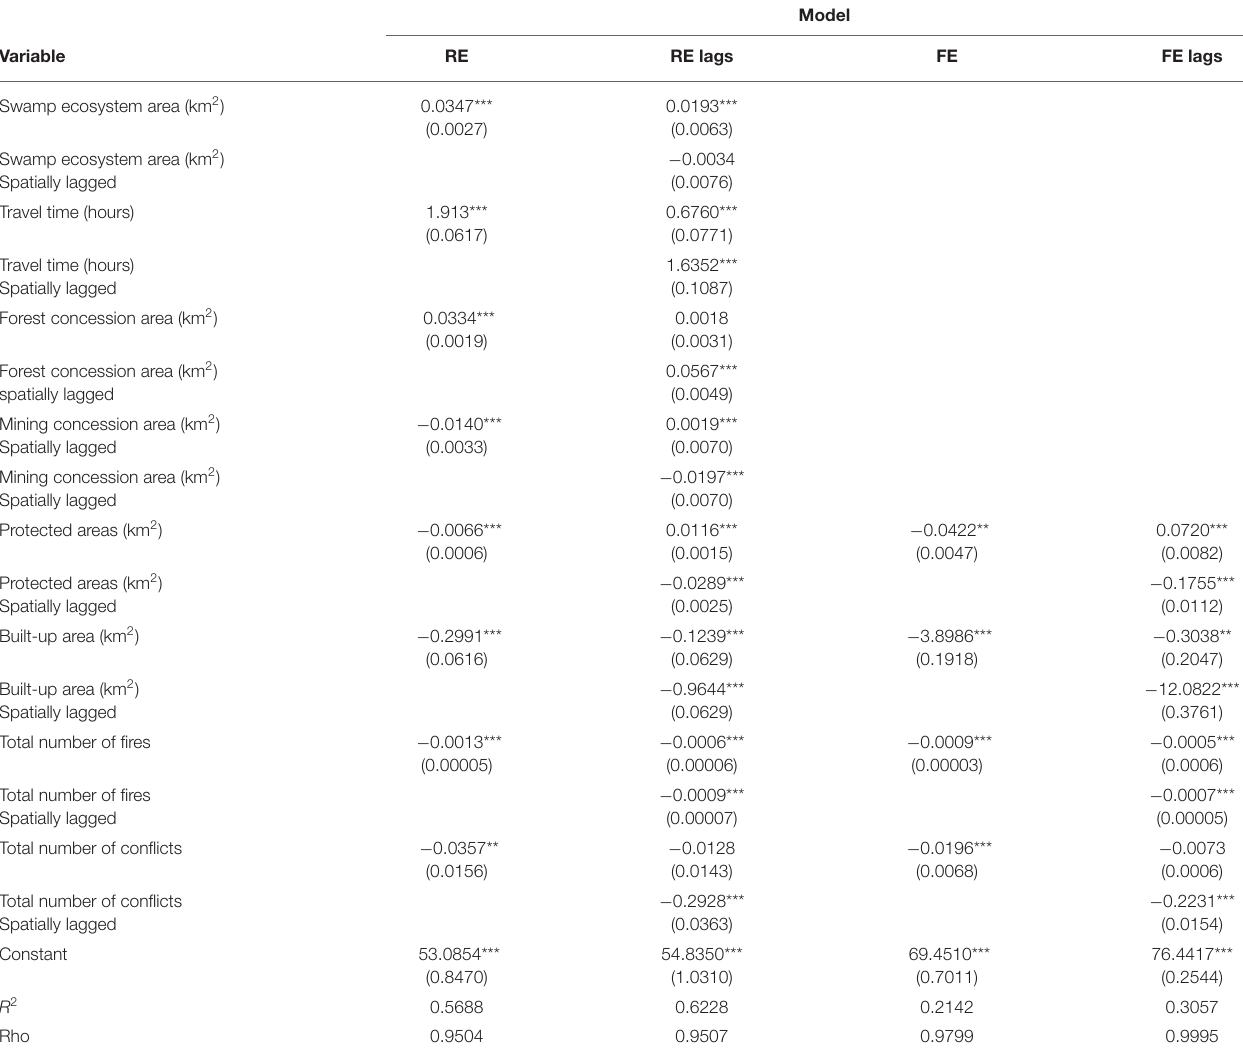
TABLE 4 | Results of random effects (RE), RE with lags, and fixed effects (FE), FE with